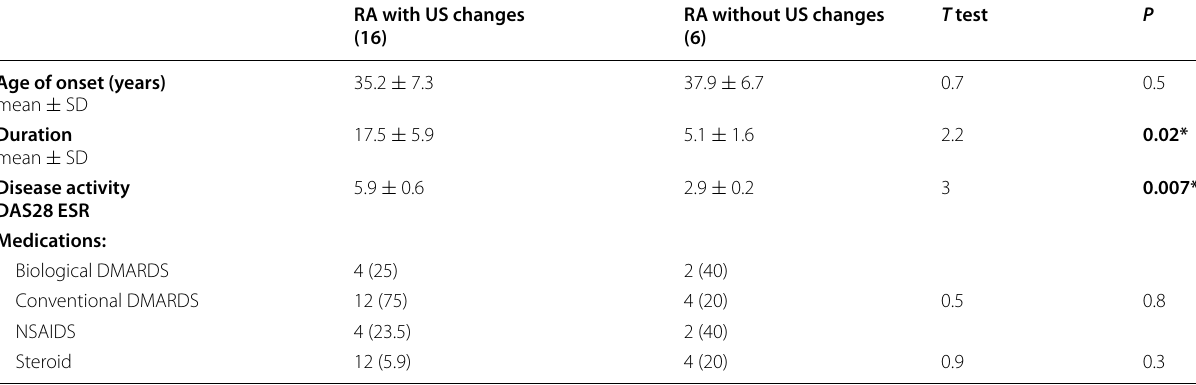
RA rheumatoid arthritis, US ultrasonography, SD standard deviation, n number, DAS28 Disease Activity Score-28, DMARDs disease modifying agents for rheumatic diseases, NSAIDs non-steroidal anti-inflammatory drugs